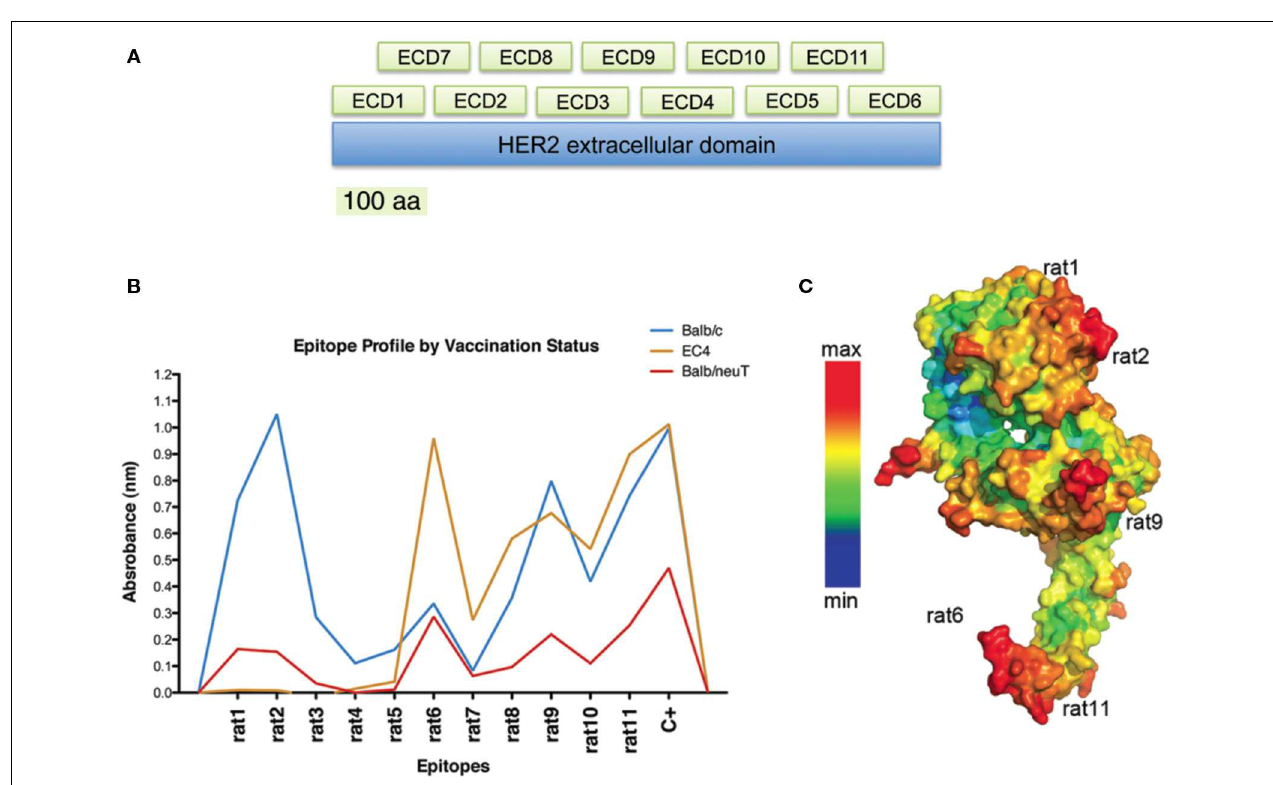
(107–216 aa), rat9 (267–376 aa), and rat11 (487–596 aa) conformational epitopes, although tolerant mice sera showed lower reactivity. Sera from mice vaccinated with a truncated form of HER2 (EC4-TM) recognized rat6 (547–656 aa), rat9, and rat11 fragments (orange line). Pepito based analysis of rat HER2 (C) . Red zones indicate the maximum probability of finding a conformational epitope. Adapted from Gabrielli et al.